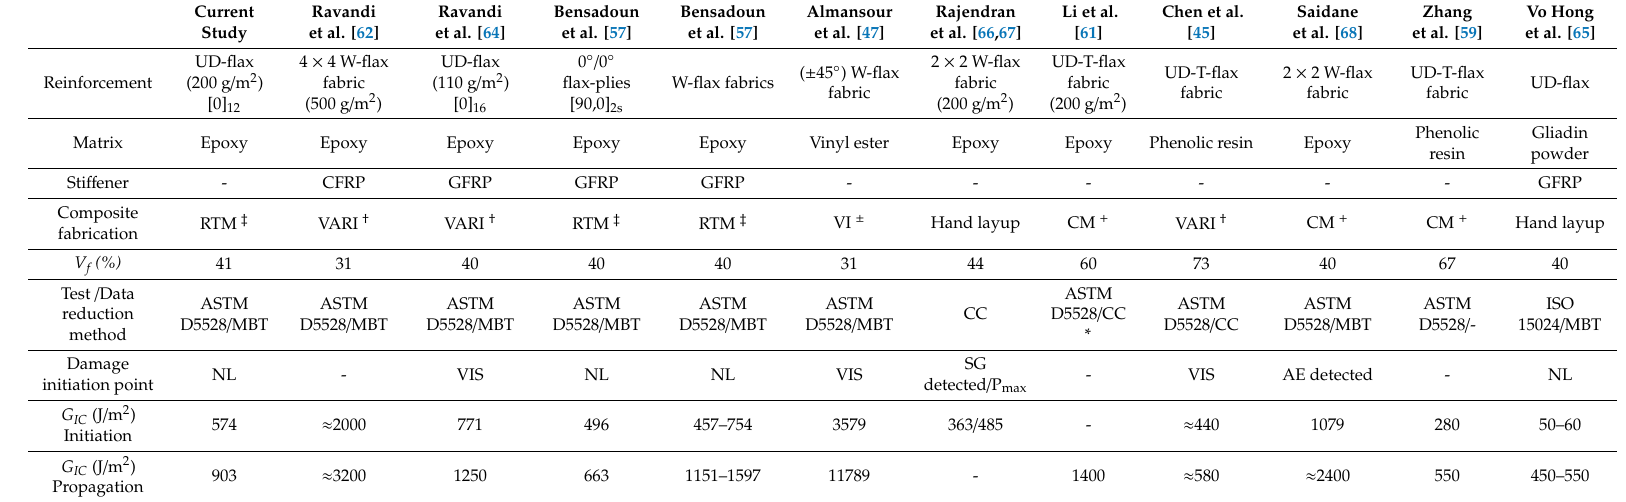
Table 2. Mode I interlaminar fracture toughness tests and values for